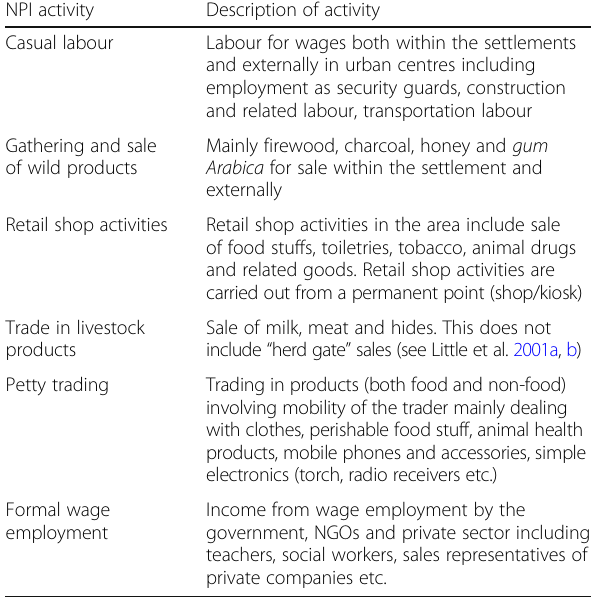
Table 4 Non-pastoral income activities in the study settlements NPI